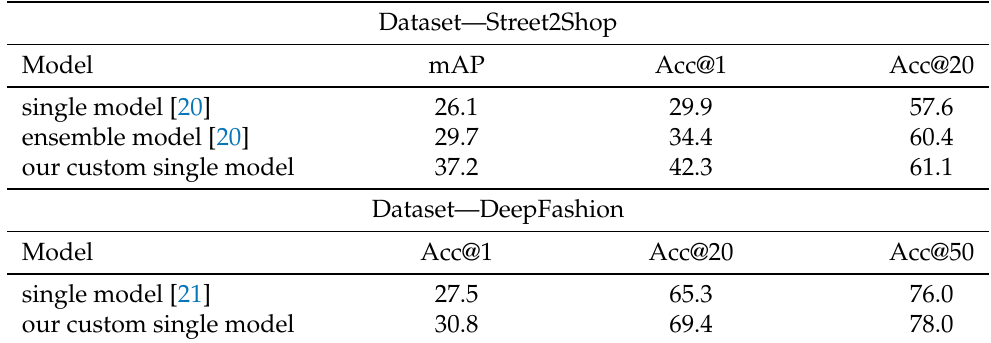
Table 1. Comparison of performance on our models and published SotA in visual similarity research. The chosen metrics are commonly used in the task